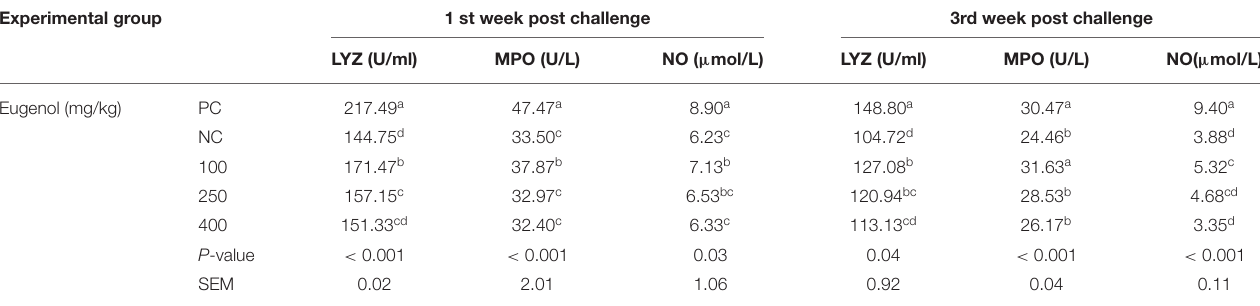
TABLE 6 | Effects of dietary supplementation of different levels of eugenol nanoemulsion on serum immunological parameters of broilers post challenge with E. coli O78. Experimental group 1 st week post challenge